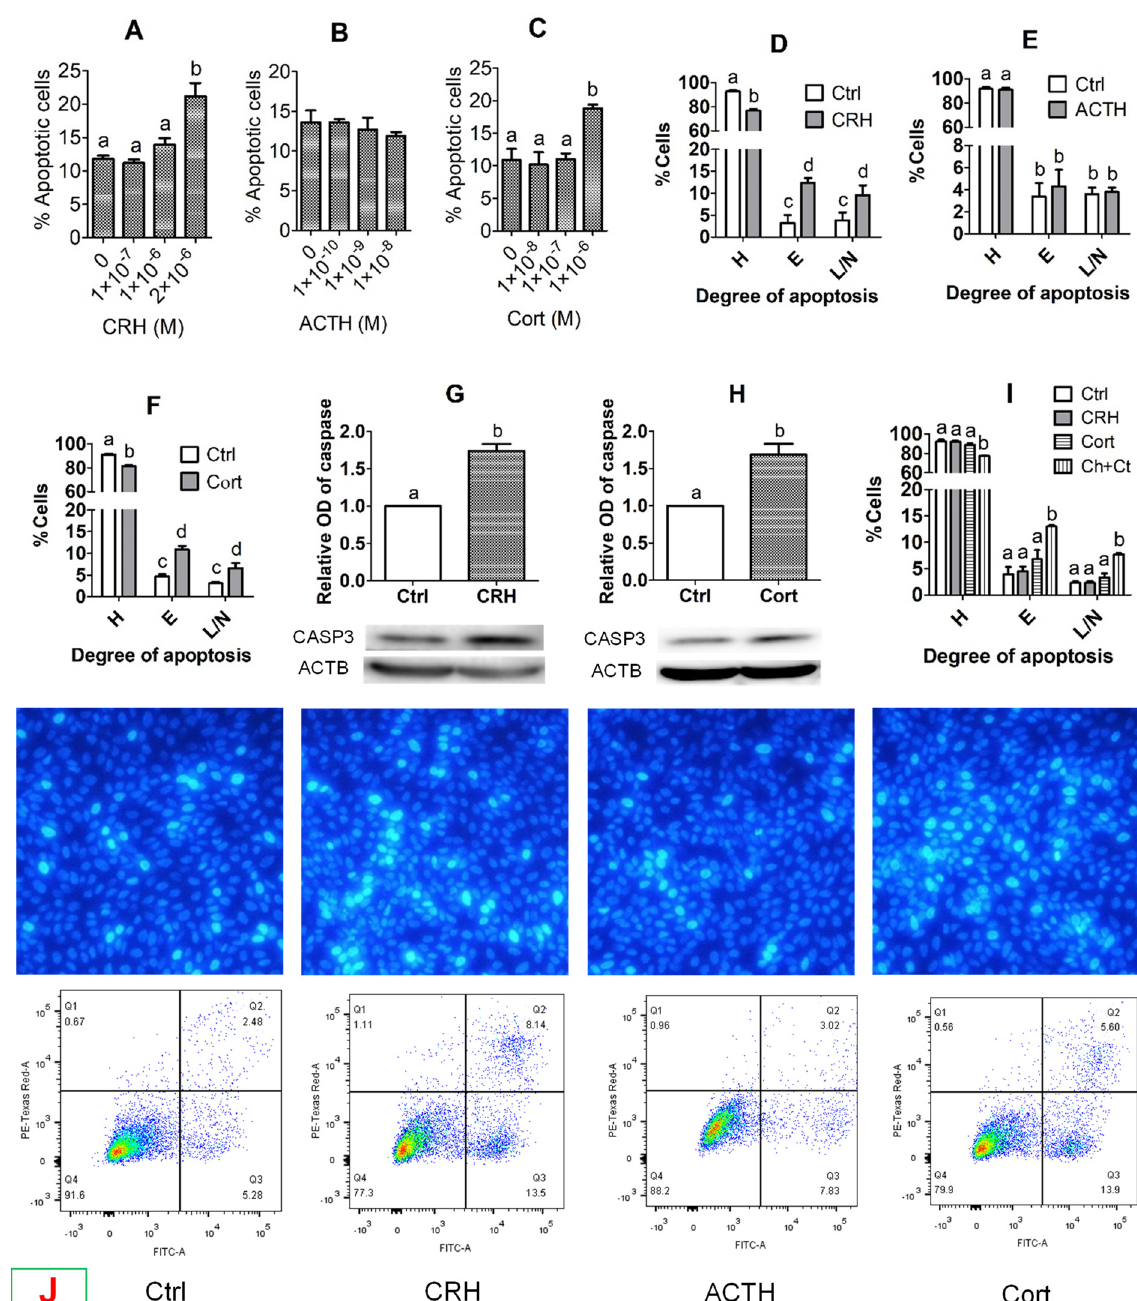
Figure 2. Effects of treatment with corticotrophin-releasing hormone (CRH), adrenocorticotropic hormone (ACTH) or cortisol (Cort) on the apoptosis of pig oviduct epithelial cells (OECs). While graphs ( A – C ) show Hoechst staining-revealed percentages of apoptotic cells following culture of OECs with different concentrations of CRH, ACTH or Cort, respectively, graphs ( D – F ) show flow cytometry-revealed percentages of healthy ( H ), early apoptotic ( E ) and late apoptotic/necrotic (L/N) cells, following the culture of OECs with CRH (2 × 10 − 6 M), ACTH (1 × 10 − 8 M) or Cort (1 × 10 − 6 M), respectively. Graphs ( G , H ) show relative levels of active caspase 3 (CASP3) as revealed by Western blotting after the OECs were cultured with CRH (2 × 10 − 6 M) and Cort (1 × 10 − 6 M), respectively. Graph ( I ) shows flow cytometry-revealed percentages of healthy ( H ), early apoptotic ( E ) and late apoptotic/necrotic (L/N) cells, following the culture of OECs without hormone (Ctrl) or with CRH (1 × 10 − 8 M) or Cort (4 × 10 − 7 M) alone or both (Ch+Ct). Each treatment was repeated three times with each replicate including cells from one well of a 12-well culture plate. a–d: Values with a different letter above bars differ ( p < 0.05). Panel ( J ) shows micrographs after Hoechst 33342 staining (upper